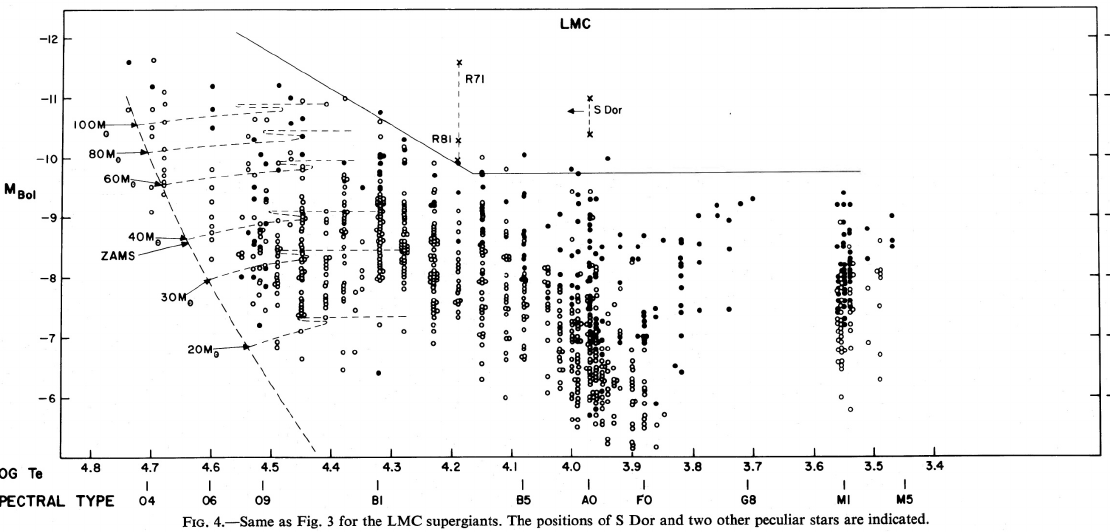
Figure 3. The HR Diagram, M Bol vs. log T, for the luminous stars in the LMC from